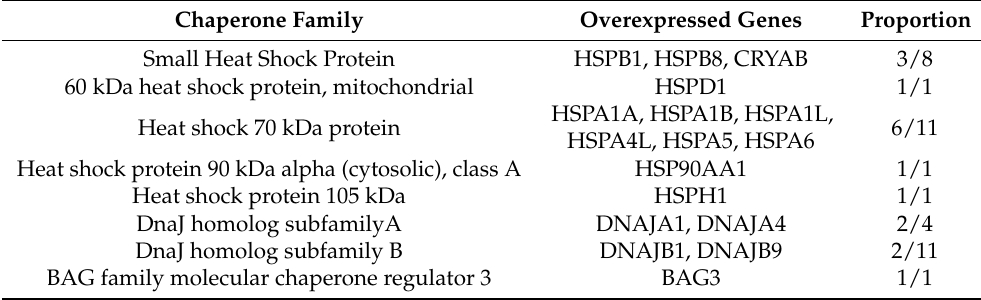
Table 3. Classification of overexpressed genes according to Heat Shock Protein or